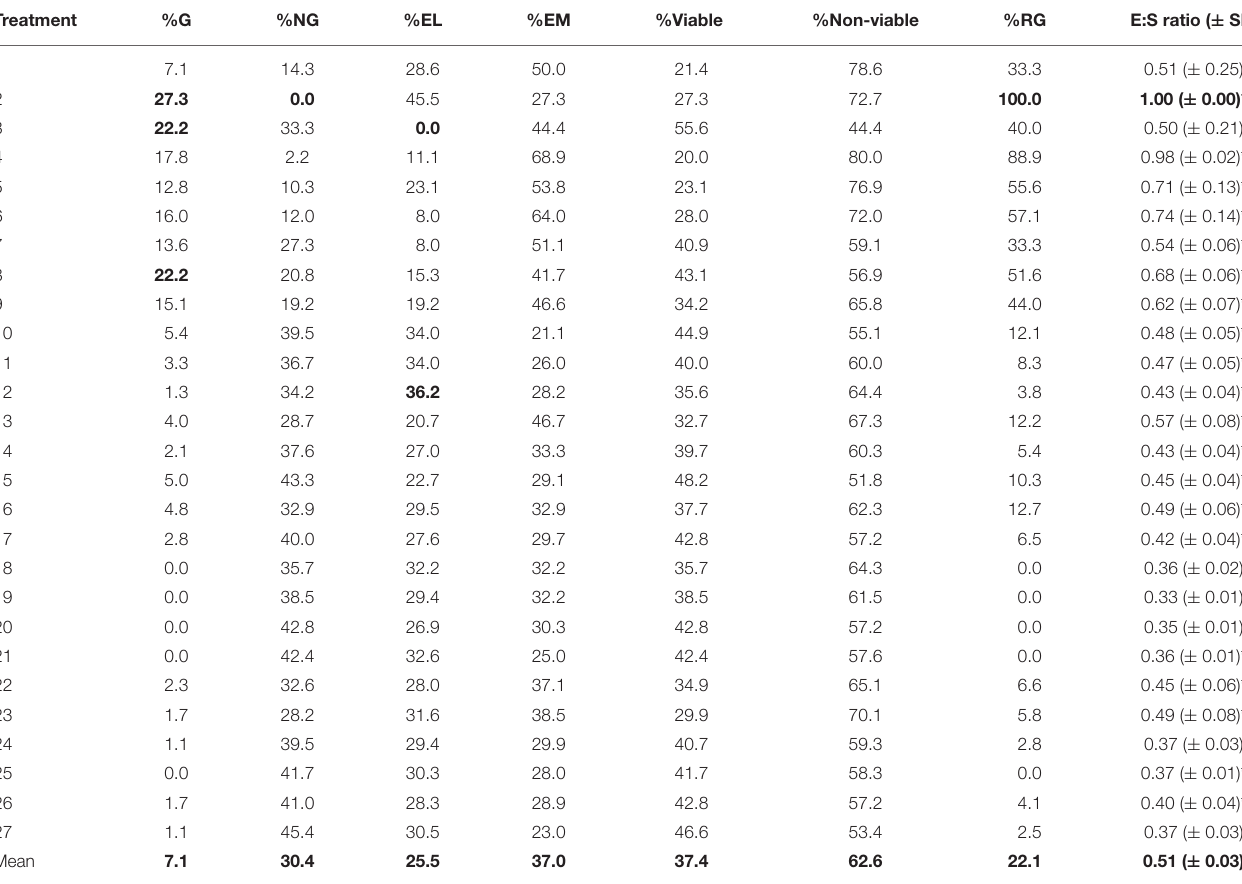
TABLE 3 | Percentage of germination (%G), no germination (%NG), embryoless seeds (%EL), empty seeds (%EM), viable (%G + %NG), non-viable (%EL + %EM) seeds, real germination (%RG), and mean and standard error of the E:S ratio. Treatment